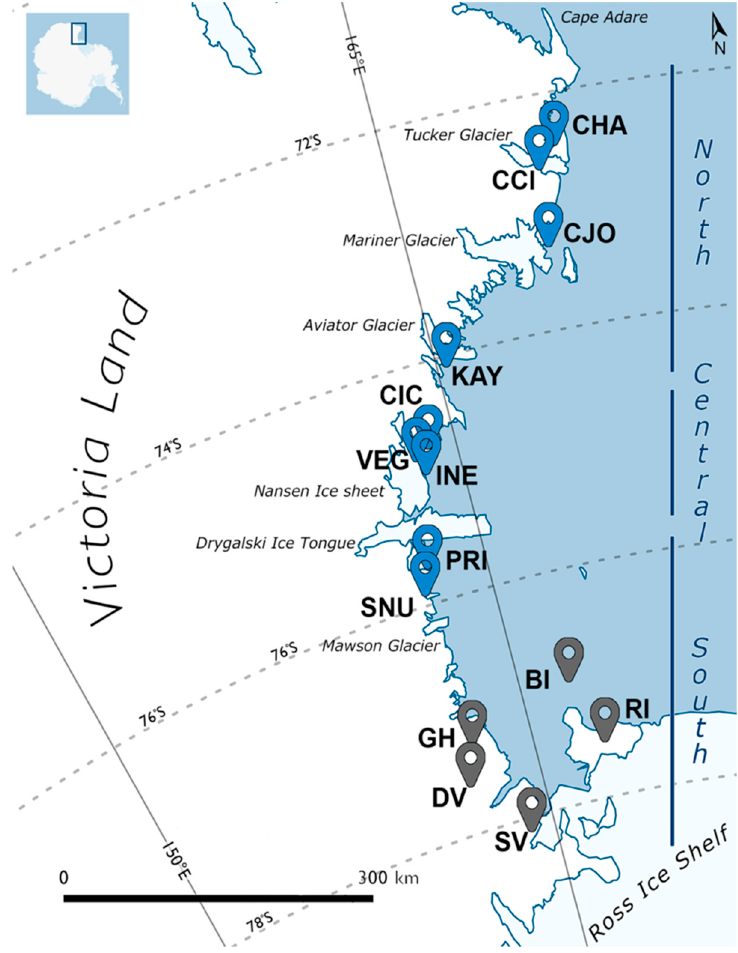
Figure 1. Map of sampling localities for the Stereotydeus spp. samples analyzed in this study (blue; see Table 1 for locality abbreviations) and in published studies of S. mollis [33,34,36] (dark grey): DV = McMurdo Dry Valleys (Taylor, Wright and Victoria Valleys and vicinity), SV = southern Dry Valleys (Garwood, Marshall and Miers Valleys and vicinity), BI = Beaufort Island; RI = Ross Island and GH = Granite Harbour (coastlines from ADD Simple Basemap, NPI/Quantarctica 3 [60]).